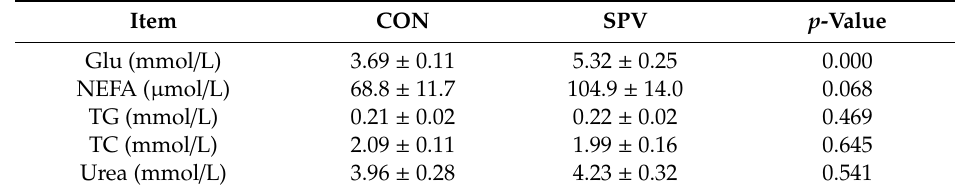
Table 3. E ff ect of sweet potato vine treatment on plasma metabolic substrates in Meishan